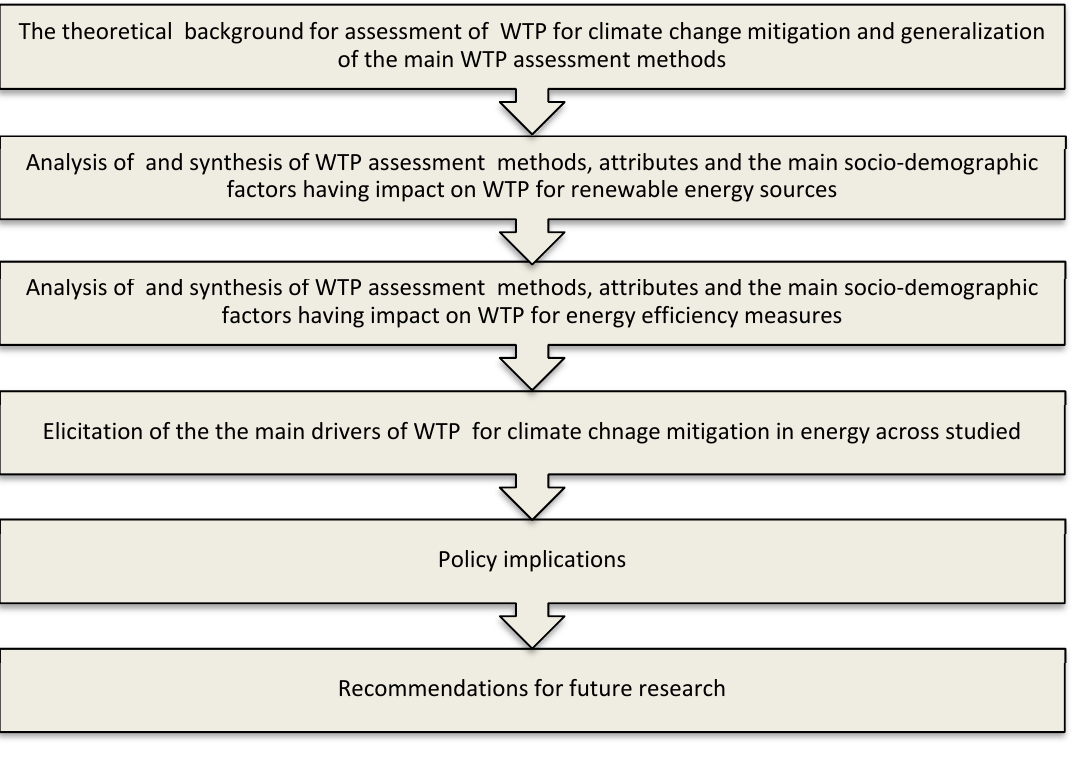
Figure 1. The main steps of implemented methodology.